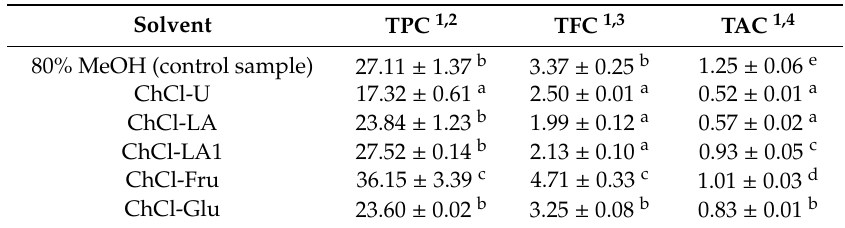
Table 2. Average extraction yields for TPC, TFC and TAC obtained after extraction with di ff erent NADESs (NADES / water = 2 / 1 v / v ) and with 80%